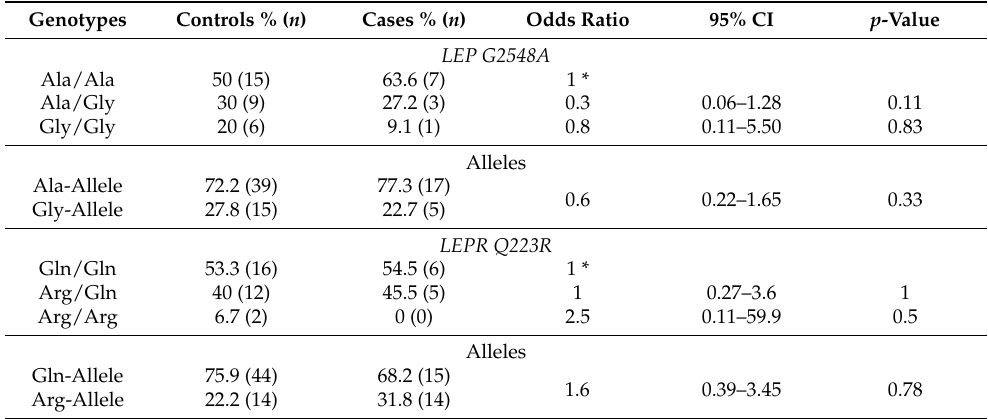
Table 7. Results of G2548A Lep and Q223A LepR of controls and Group 2 cases with BMI < 18 (Underweight to Anorexic) and no abnormal sleeping, eating, and stress parameters.